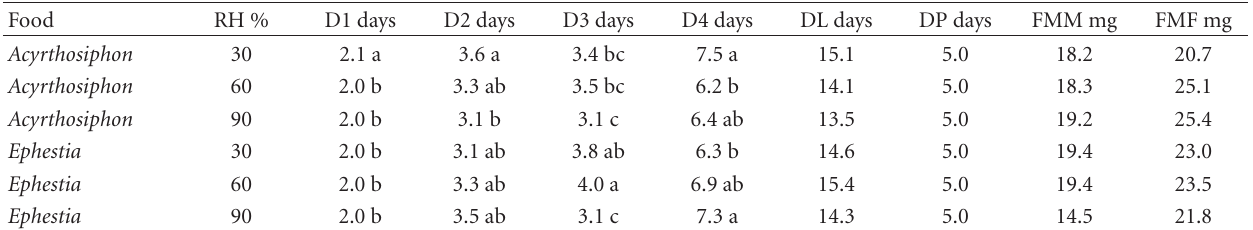
Table 2: Developmental time (days) and adult fresh mass (mg) of Harmonia axyridis reared on two diets and in three levels of relative air humidities at 25 ◦ C and 16L :8D photoperiod. D1 to D4, DL and DP: development time of particular larval instar, entire larval stage, and pupa, FMM: fresh mass of males, FMF: fresh mass of females. Means that do not di ff er significantly are marked with the same letter in each